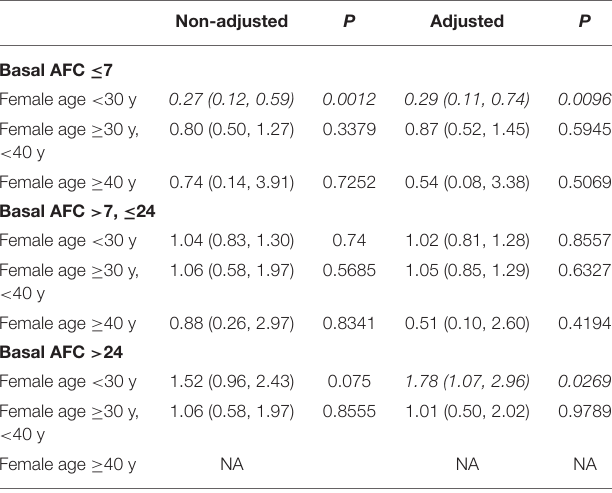
TABLE 3 | Comparison of cLBR of flexible GnRH antagonist protocol vs. GnRH agonist long protocol using multivariable regression analysis in patients stratified by AFC and